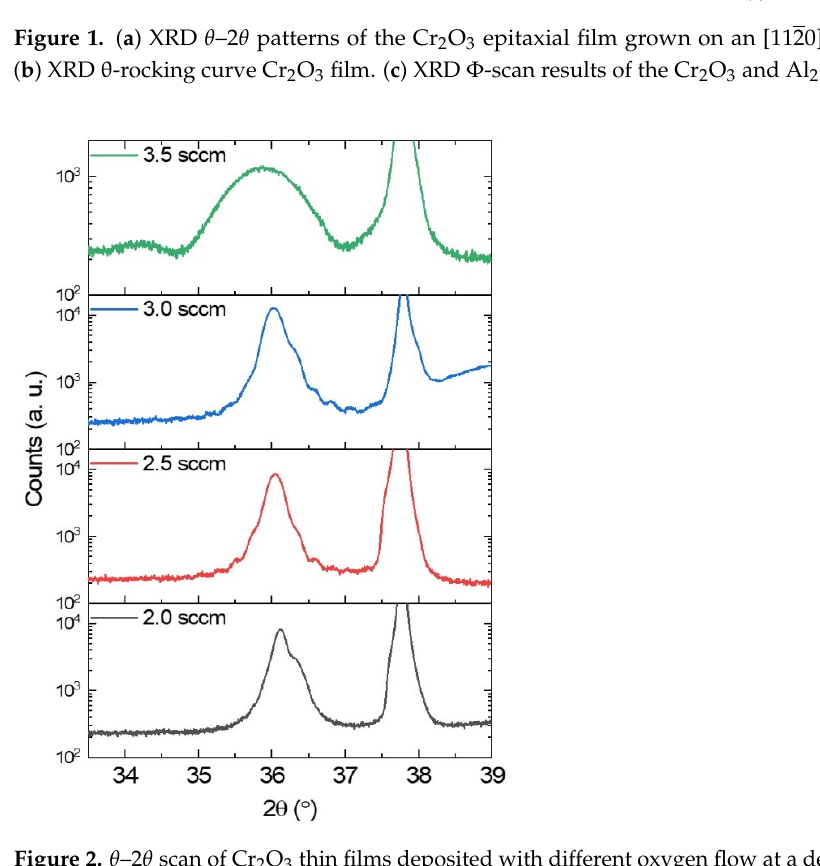
Figure 2. θ –2 θ scan of Cr 2 O 3 thin films deposited with different oxygen flow at a deposition pressure of 5 mTorr and temperature of 675 °C with 150 W RF